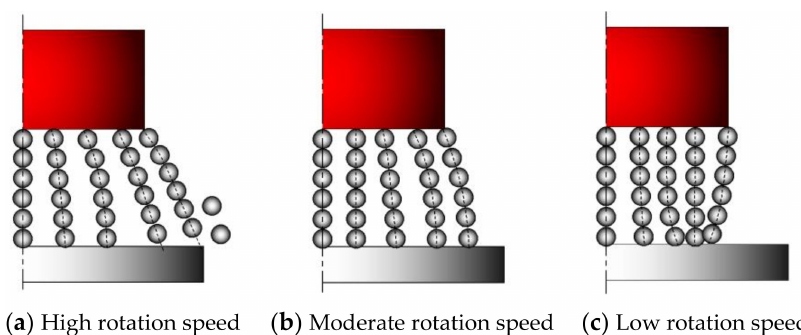
Figure 3. Three magnetic brush states during MAF